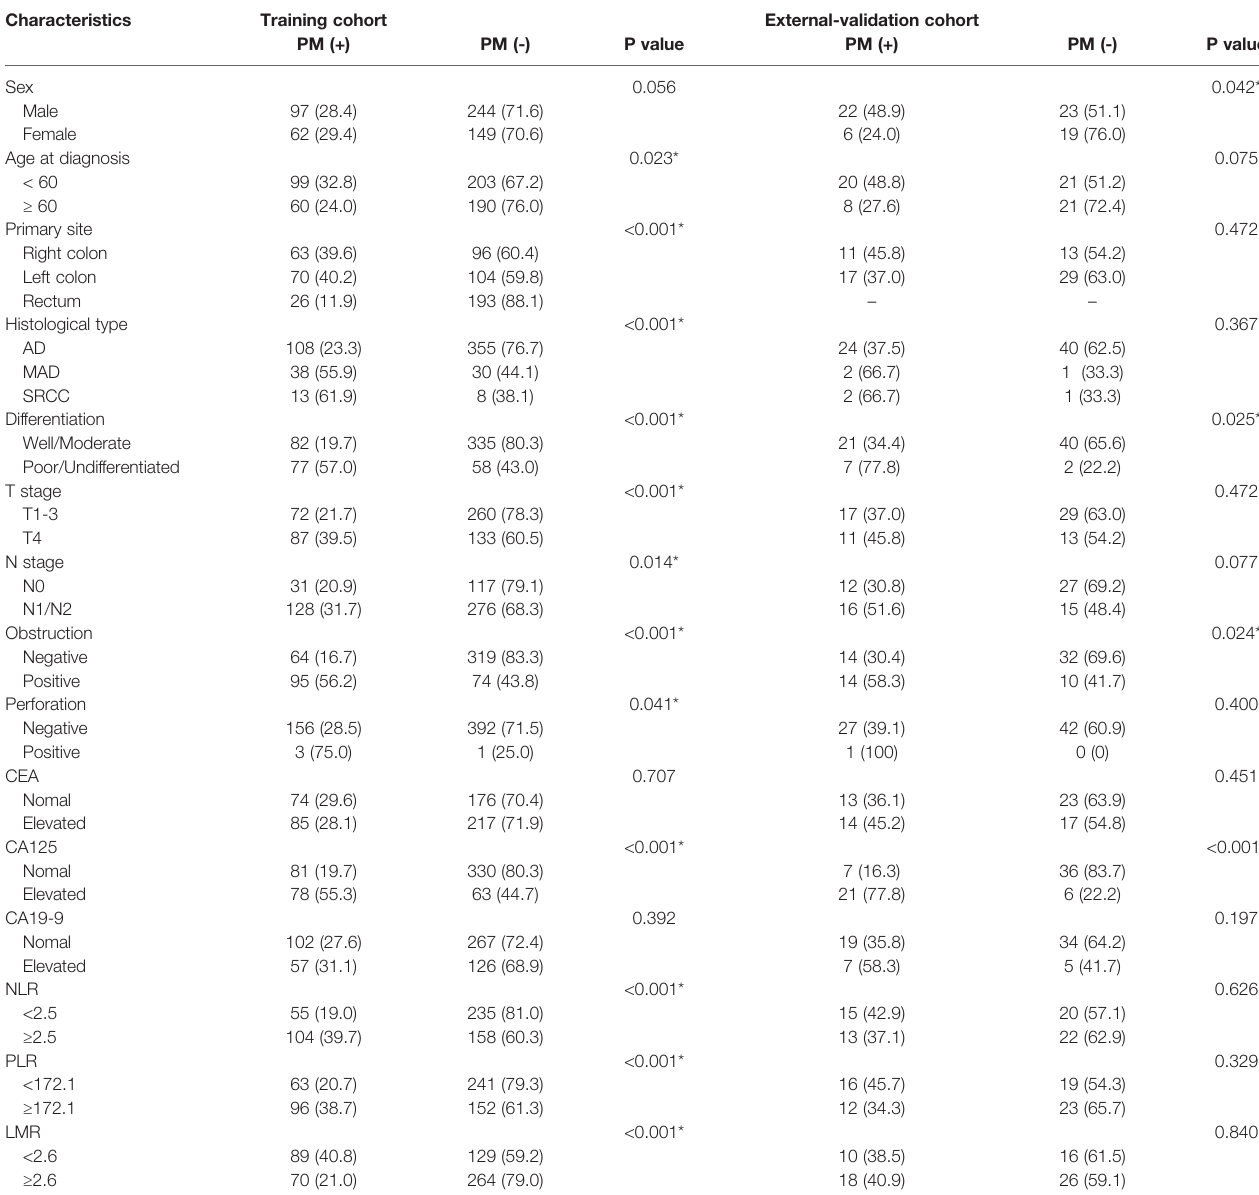
TABLE 1 | Characteristics of patients in the training and validation